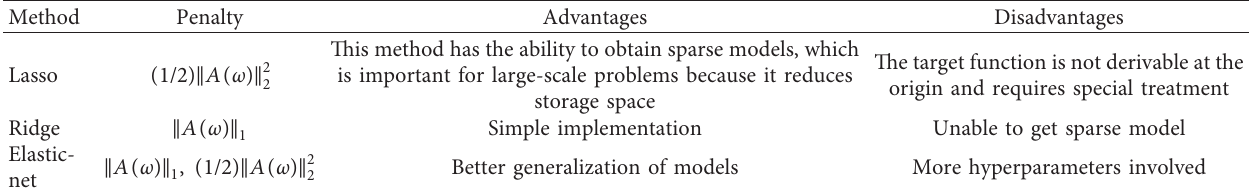
Table 1: Comparison of regularization methods.